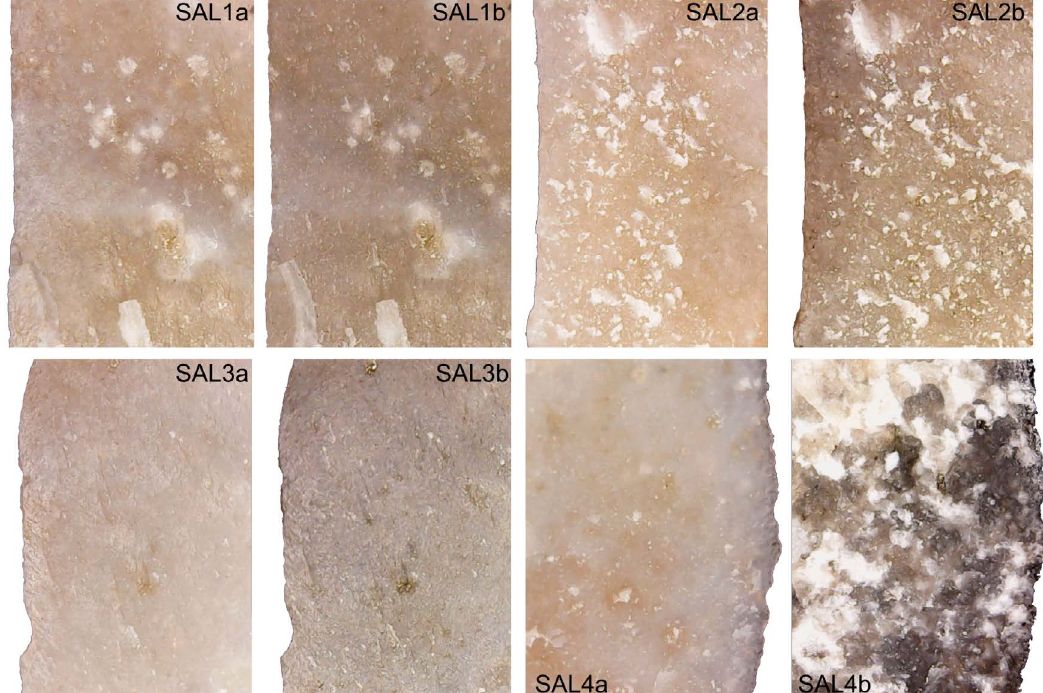
Figure 6. Described Surface Alteration Levels (SAL) for SMM flint. SAL 1a and 1b where dehydration is almost absent and the developed color is almost absent; SAL 2a and 2b with a higher development of dehydration, higher topographic visibility, and development of the characteristic waxy luster; SAL 3a and 3b where surface has been blackened because of carbonization; SAL 4a and 4b where surface presents a spongy surface due to extreme dehydration and associated with color white of